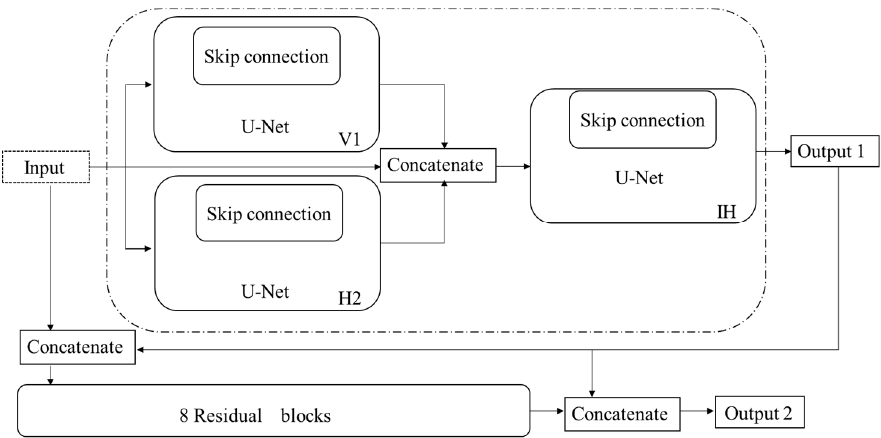
Figure 8. The network architecture in references [21] and [22].